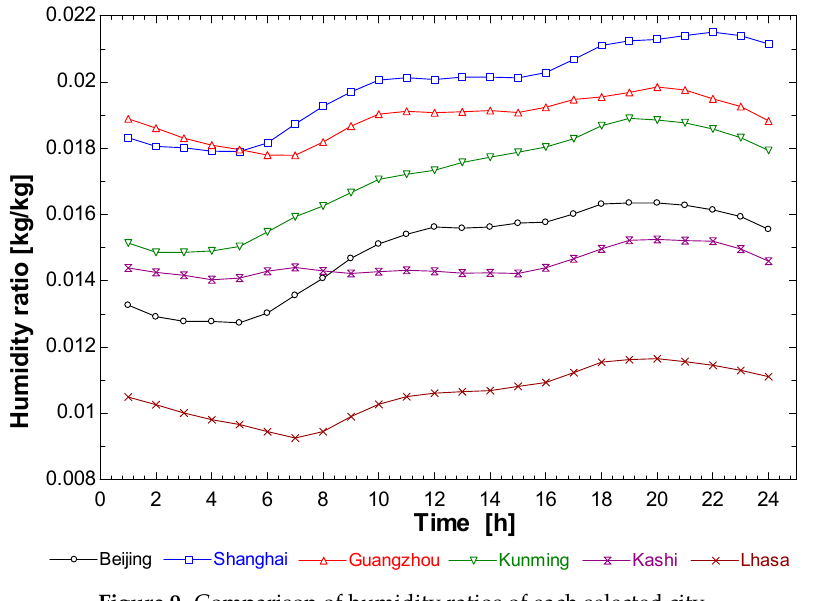
Figure 9. Comparison of humidity ratios of each selected city.